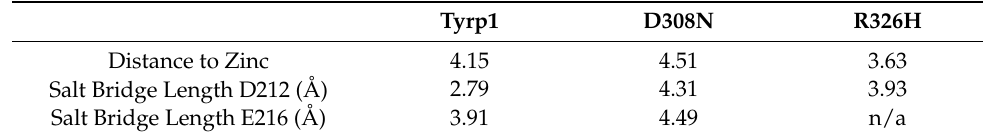
Figure 7. Docked DHICA interaction with Tyrp1 ( A ), D308N ( B ), and R326H ( C ). Tyrp1 and D308N have six total interac- tions with DHICA: four hydrogen bonds and two salt bridges. R326H has two fewer interactions with DHICA: three hydrogen bonds and one salt bridge. Table 3. Ligand–receptor interaction-related distances. Table 3. Ligand–receptor interaction-related distances.